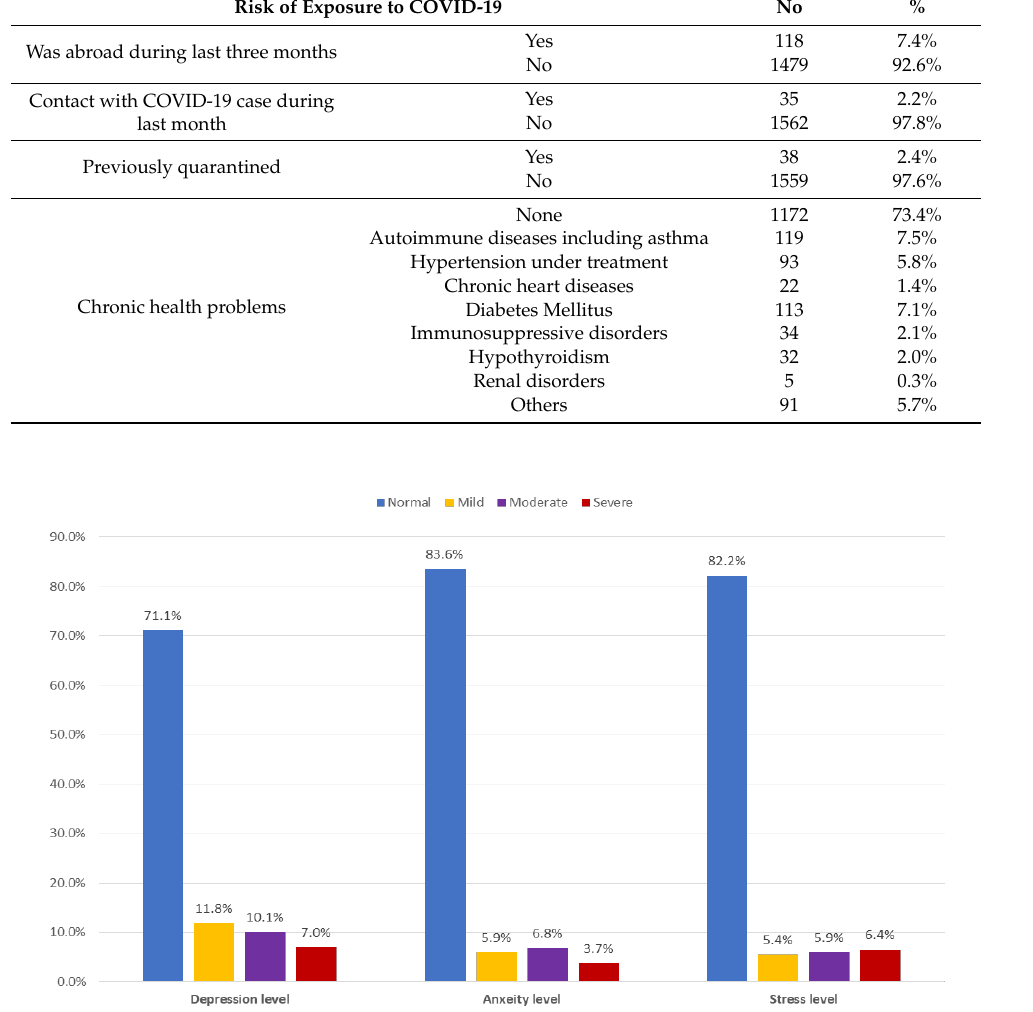
Figure 1. Distribution of psychological health parameters among general population in Saudi Arabia during COVID-19 pandemic, 2020.